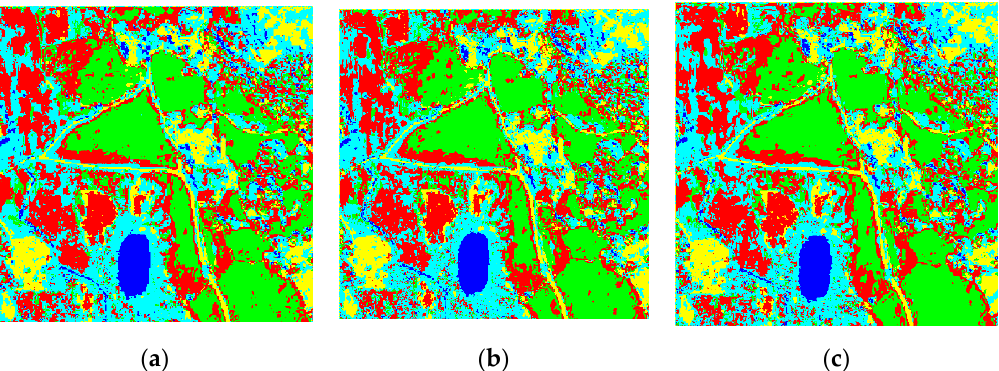
Figure 9. Classification results: for original image ( a ), for compressed image (PSNR-HVS-M = 36 dB) ( b ), for compressed (PSNR-HVS-M = 30 dB) ( c ).